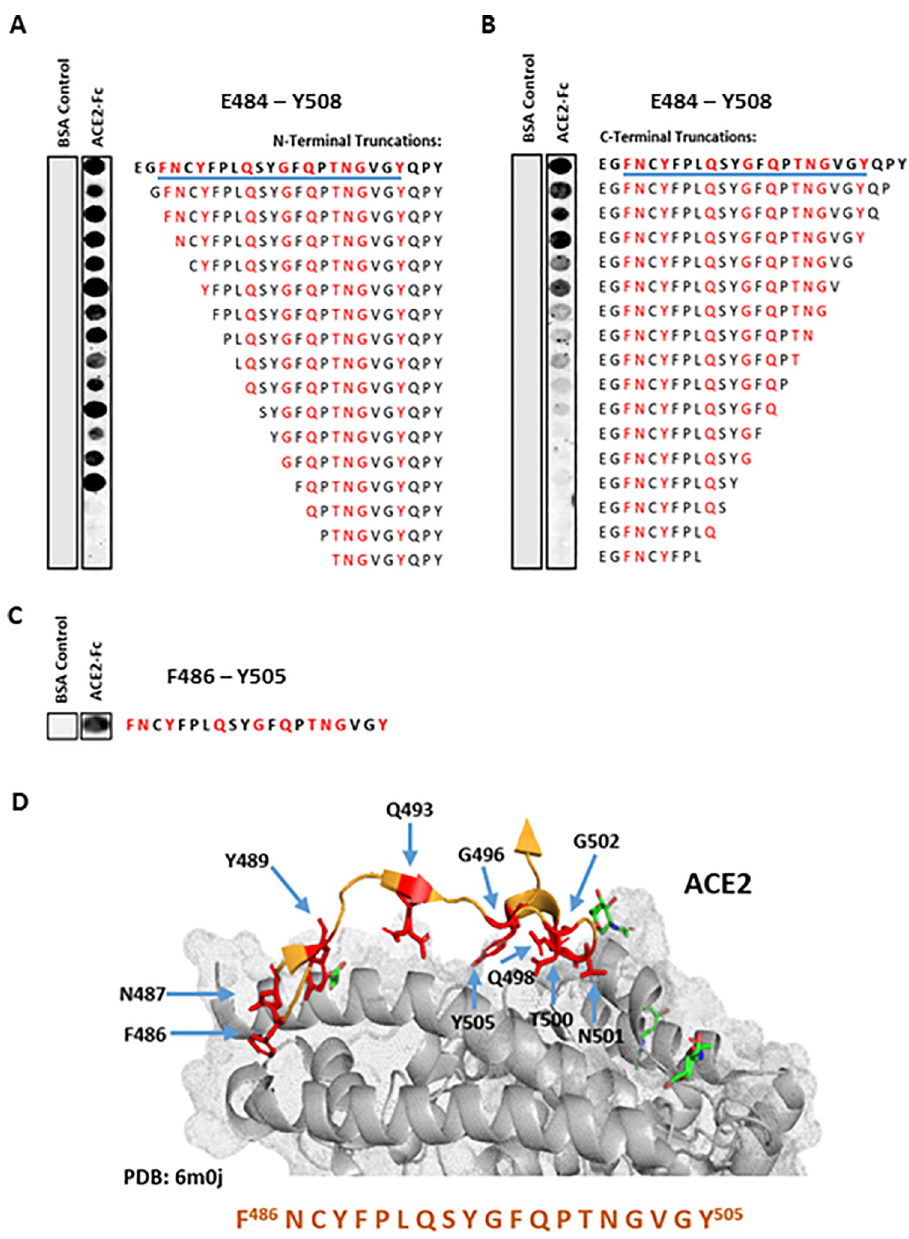
Fig 3. Selecting a potential RBD–ACE2 PPI inhibitor peptide derived from SARS-CoV-2 RBM E484 –Y508. (A) N-terminal and (B) C-terminal stepwise truncation peptide array of RBM E484 –Y508, overlaid with ACE2-Fc human purified protein. Underlined (blue) sequence represents shorter sequence peptide selected for assessment in vitro . (C) ACE2 binding to short sequence RBM 20mer; F486 –Y505. (D) Structure of F486 –Y505 SARS-CoV-2 RBM and the respective binding interface of ACE2 receptor; RBM interacting residues highlighted in red–adapted